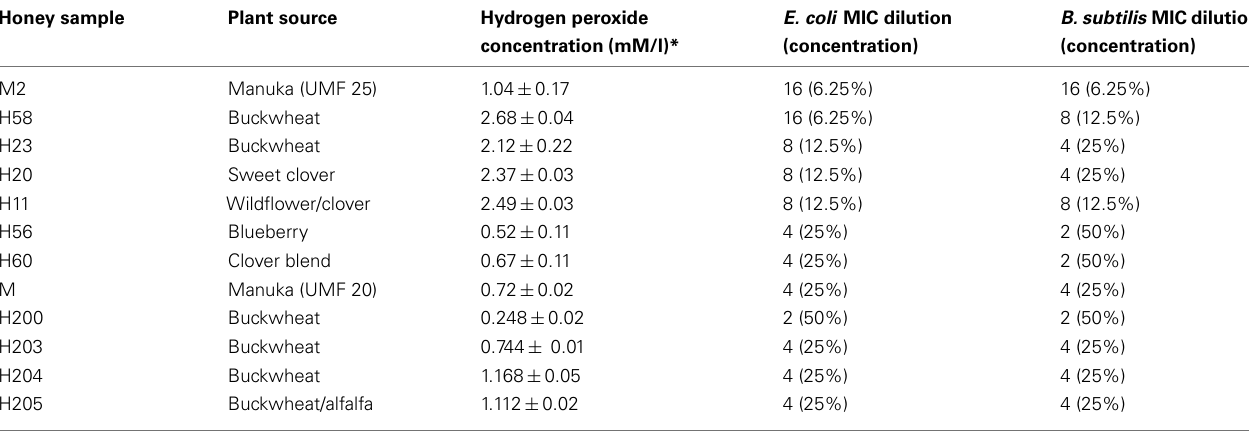
Table 1 | Hydrogen peroxide concentrations in different honeys. Relationship between antibacterial activities of honey and hydrogen peroxide